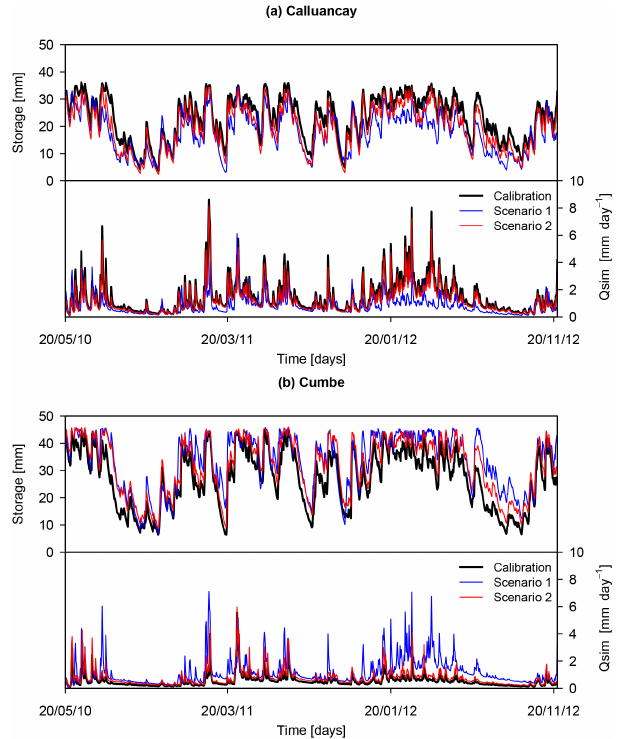
Figure 8. Soil water storage and stream discharge for the experi- mental catchments as result of the two climate scenarios. The sim- ulated time series for the storage and the stream discharge are in- cluded for